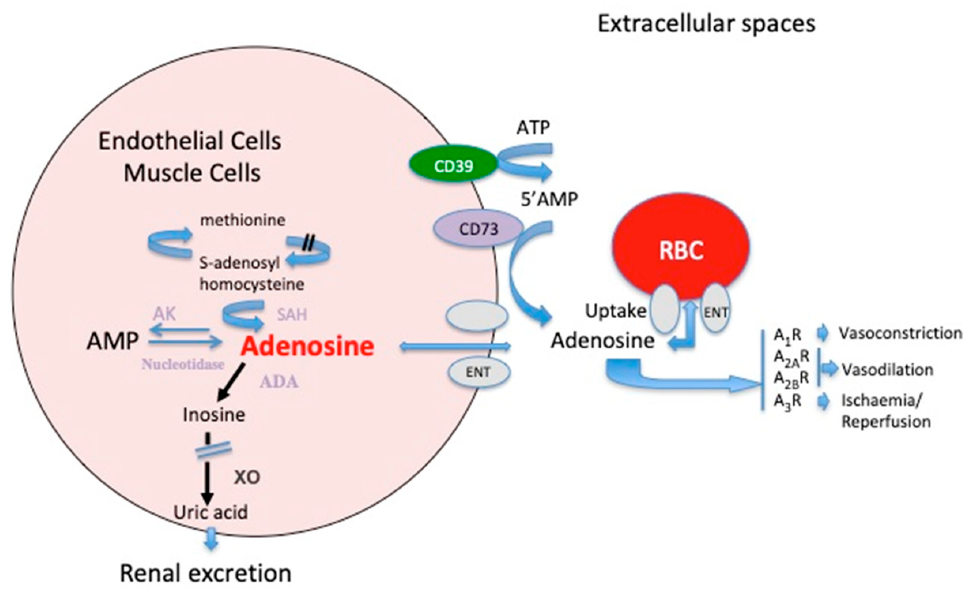
Figure 1. Schematic representation of the adenosine metabolism and its effects on vessels. At the extra cellular level, the main source of adenosine is the dephosphorylation of ATP and AMP via the ectonucleotidases CD39 and CD73. In the intracellular spaces, adenosine comes from AMP dephosphorylation though cytosolic nucleotidase. Part of adenosine comes from the methionine cycle. ADA: adenosine deaminase; AK: adenosine kinase; XO: xanthine oxidase; SAH: s-adenosyl homocysteine hydrolase; A 1 R, A 2A R, A 2B R, and A 3 R are adenosine receptor subtypes; ENT: equilibrative nucleoside transporter.